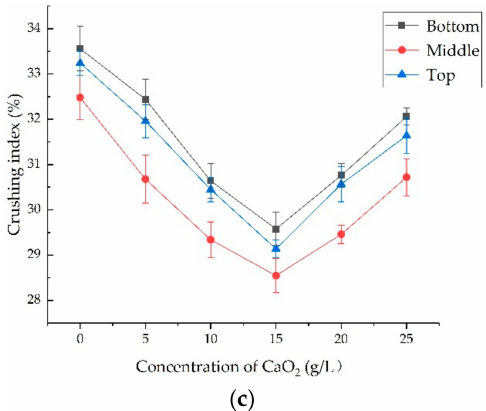
Figure 2. Properties of the treated coarse RMA: ( a ) Water absorption; ( b ) Apparent density; ( c ) Crushing